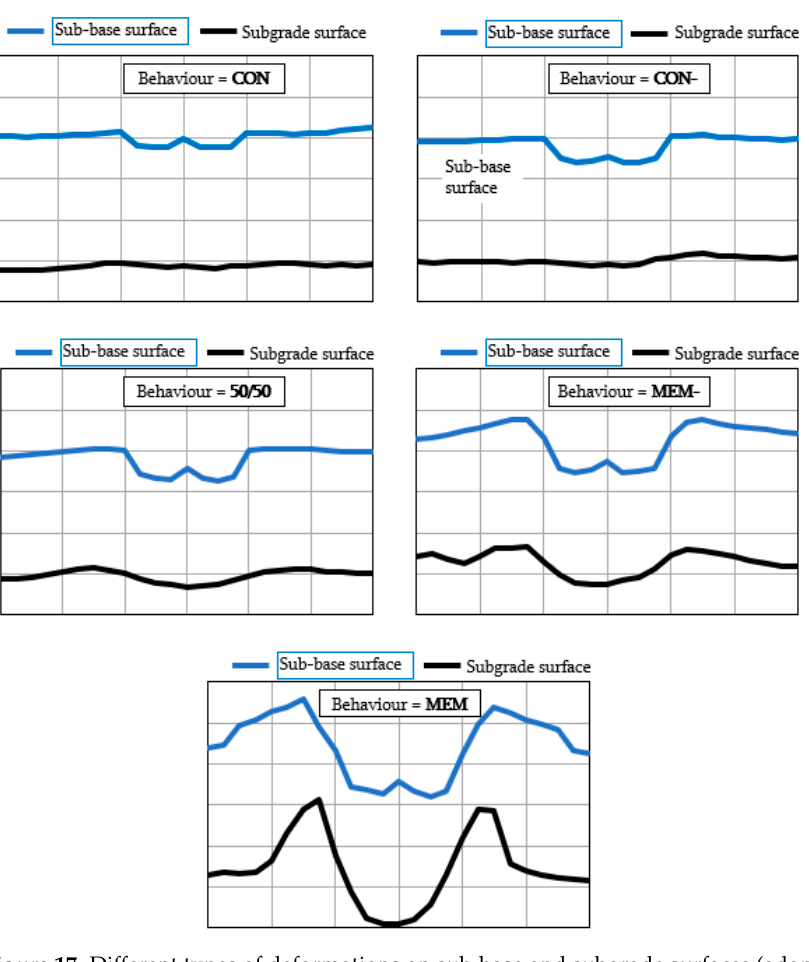
Figure 17 . Different types of deformations on sub-base and subgrade surfaces (adapted from [123]).